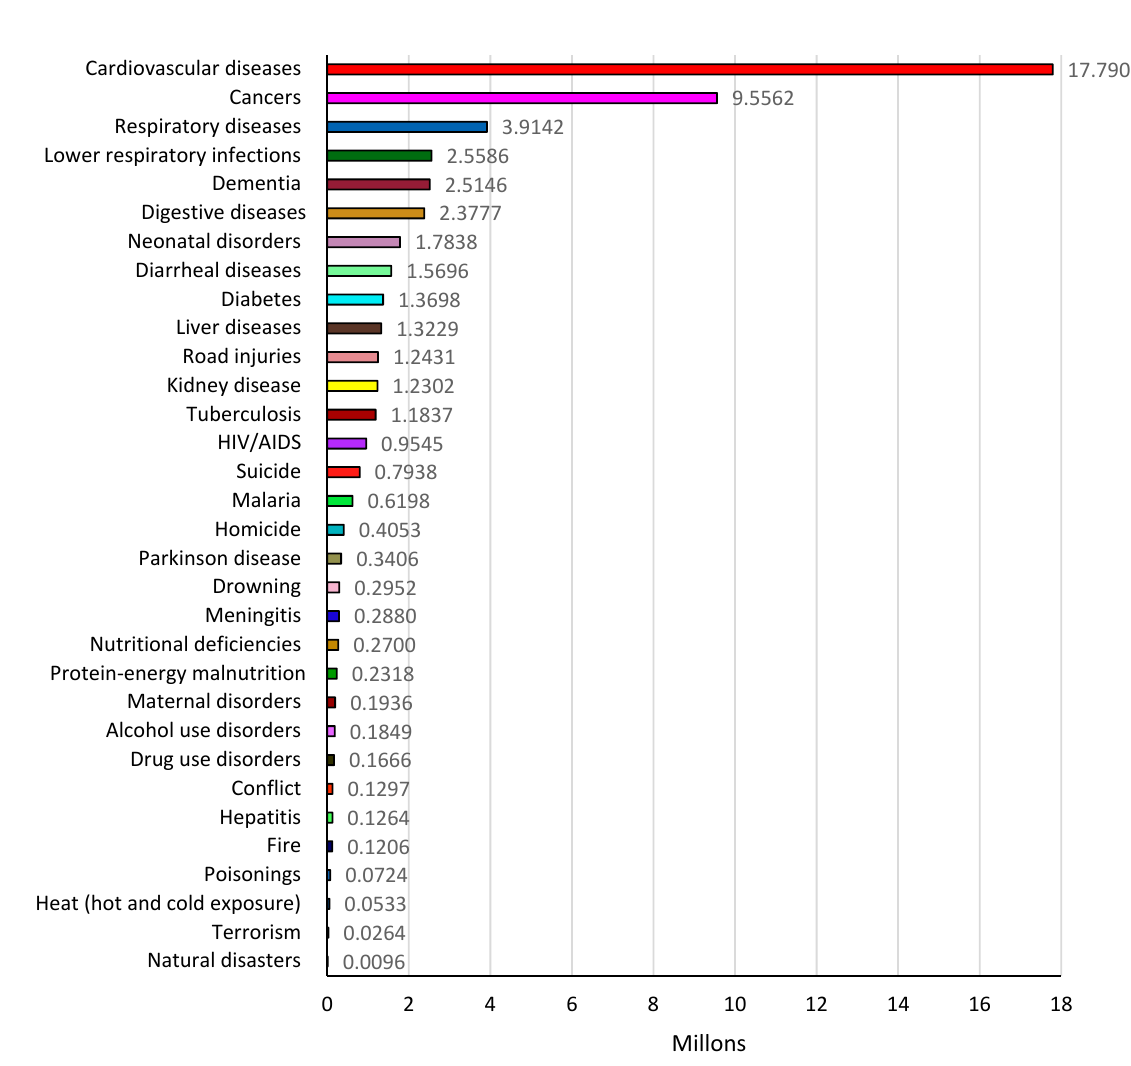
Figure 17. Breakdown of global deaths by cause, world, 2017. The information is provided as the share of annual deaths rather than the absolute number. Information provided by Hannah Ritchie and Max Roser (2019) in “Causes of Death,” published online at OurWorldInData [86].